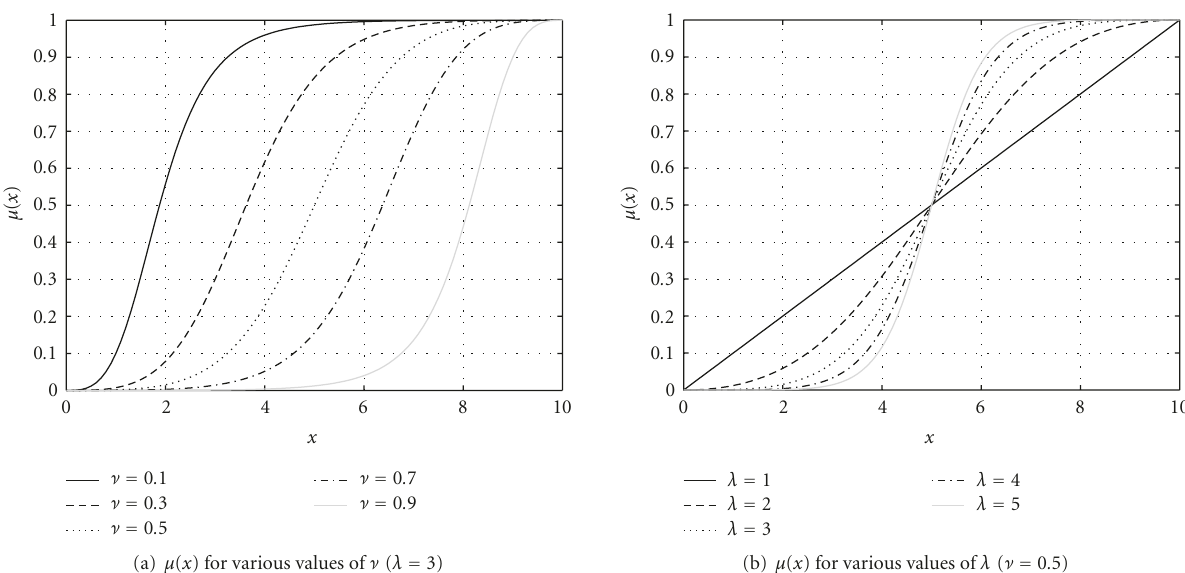
Figure 6: The generalized membership function for di ff erent parameter